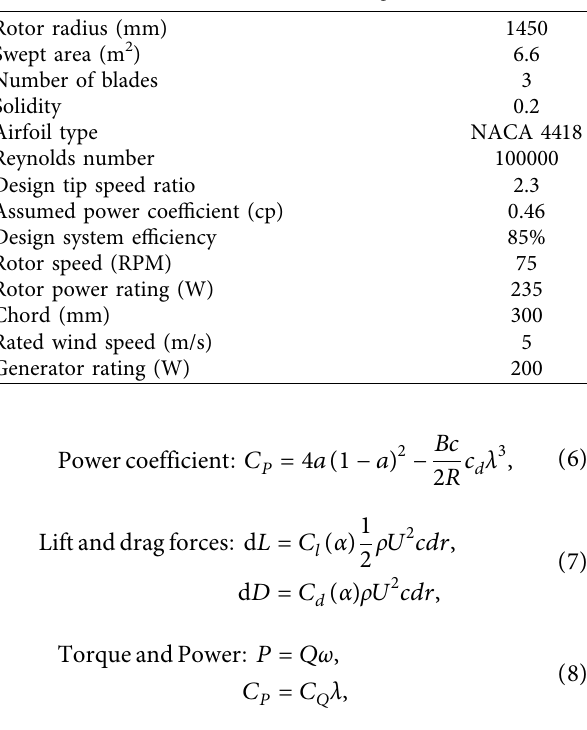
Table 1: Wind turbine configuration.